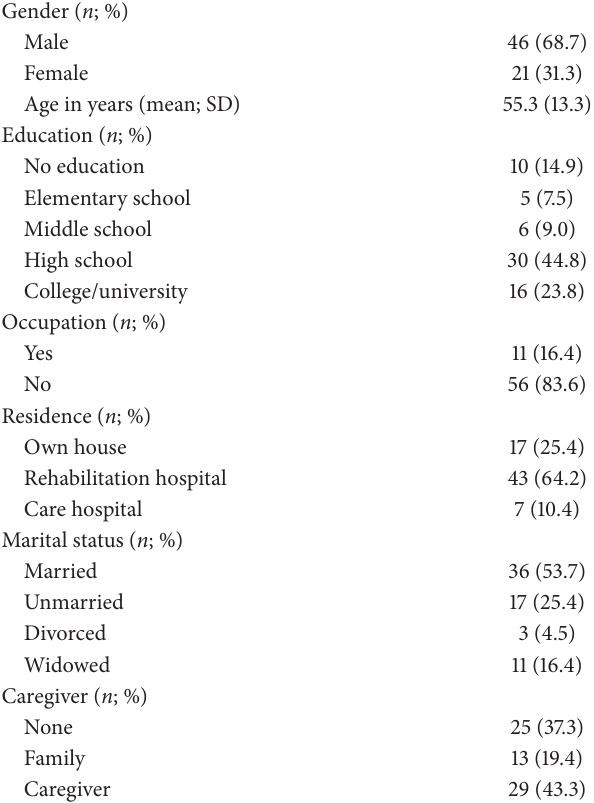
Table 1: Patient characteristics ( 𝑛 = 67 ).